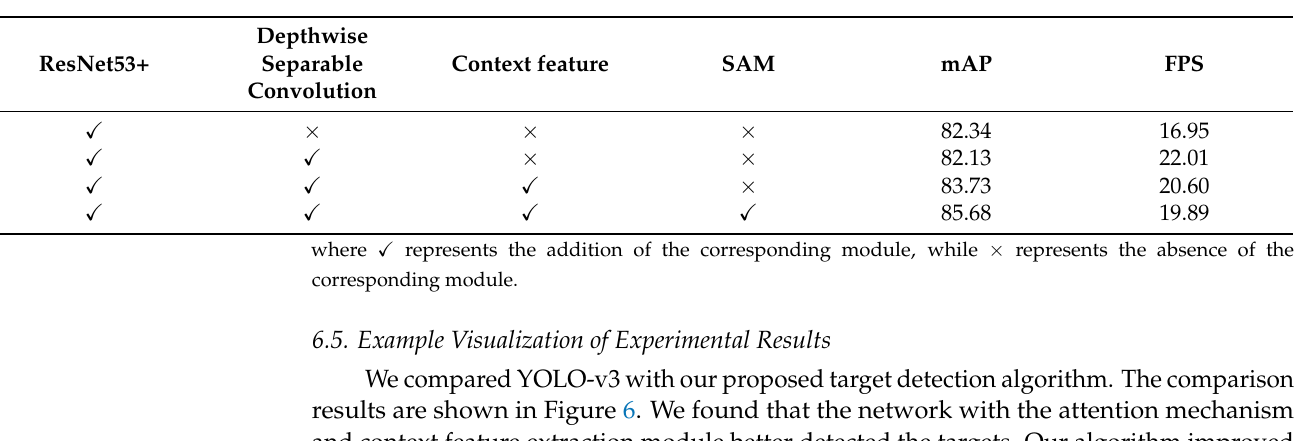
Table 5. Results of ablation